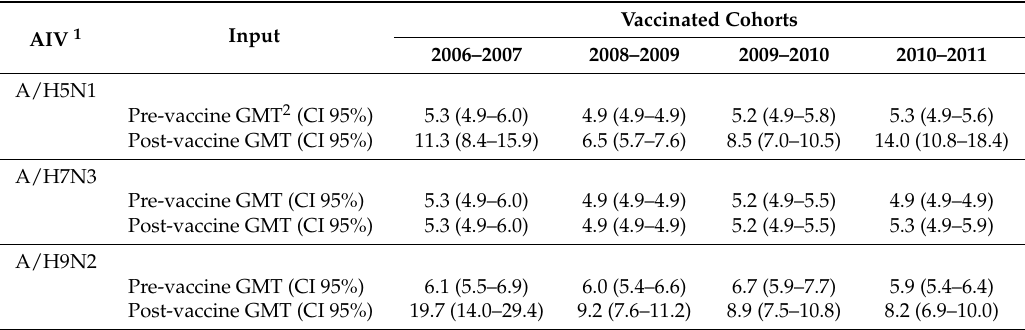
Table 3. Geometric mean titers and CI 95% observed against avian influenza viruses before and after trivalent influenza vaccination in each vaccine campaign cohort.